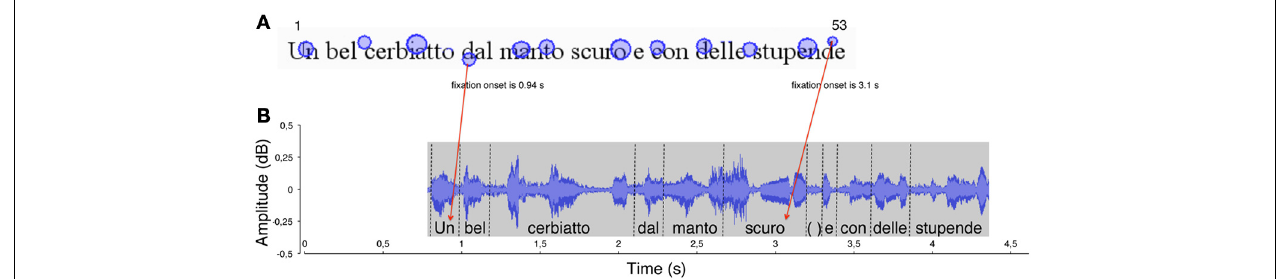
Red arrows indicate the temporal correspondence between a fixation (the grapheme “d,” of the word “dal,” letter number 18) and the phoneme that was uttered at the time of fixation (the phoneme/u/, letter number 1). Each fixation (e.g., “d,” of the word “stupende,” number 52) was